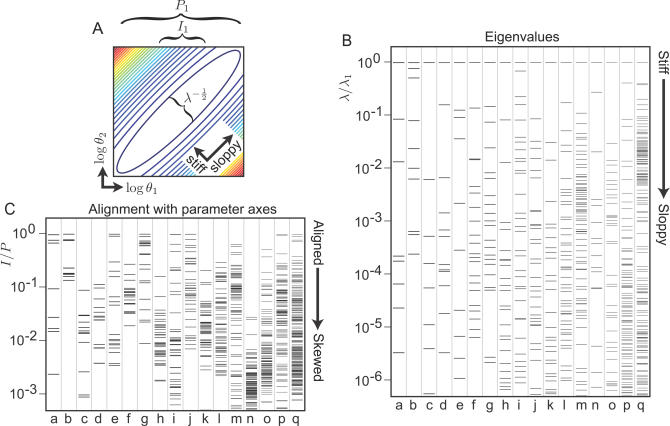
Parameter Sensitivity SpectraThe quantities we calculate from H
χ2 are illustrated in (A), while (B) and (C) show that all the models we examined have sloppy sensitivity spectra.(A) Analyzing H
χ2 corresponds to approximating the surfaces of constant model behavior change (constant χ
2) as ellipsoids. The width of each principal axis is proportional to one over the square root of the corresponding eigenvalue. The inner ellipsoid's projection onto and intersection with the θ
1 axis are denoted by P
1 and I1, respectively.(B) Plotted are the eigenvalue spectra of H
χ2 for our collection of systems biology models. The many decades generally spanned indicate that the ellipses have a very large aspect ratio. (The spectra have each been normalized by their largest eigenvalue. Not all values are visible for all models.)(C) Plotted is the spectrum of I / P for each parameter in each model in our collection. Generally very few parameters have I / P ≈ 1, suggesting that the ellipses are skewed from the bare parameter axes. (Not all values are visible for all models.)The models are plotted in order of increasing number of free parameters and are: (a) eukaryotic cell cycle [28], (b) Xenopus egg cell cycle [29], (c) eukaryotic mitosis [30], (d) generic circadian rhythm [31], (e) nicotinic acetylcholine intra-receptor dynamics [32], (f) generic kinase cascade [33], (g) Xenopus Wnt signaling [34], (h) Drosophila circadian rhythm [35], (i) rat growth-factor signaling [21], (j) Drosophila segment polarity [36], (k) Drosophila circadian rhythm [37], (l) Arabidopsis circadian rhythm [2], (m) in silico regulatory network [25], (n) human purine metabolism [38], (o) Escherichia coli carbon metabolism [39], (p) budding yeast cell cycle [40], (q) rat growth-factor signaling [41].